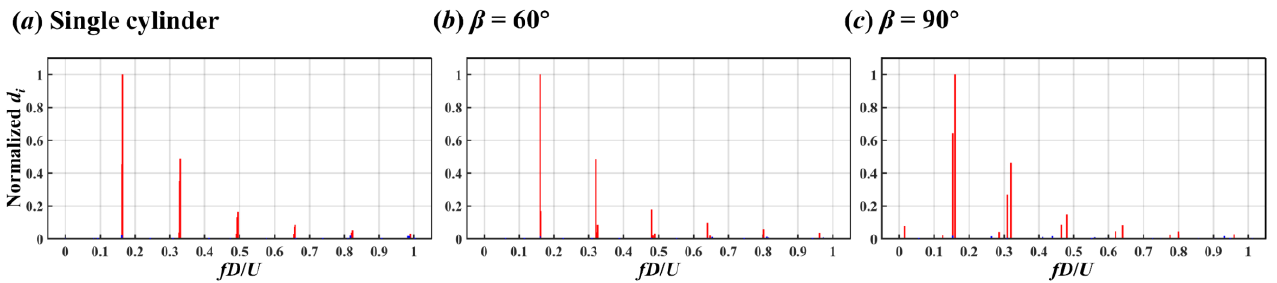
Figure 14. Spectral distribution of DMD modes for the cases of the single cylinder ( a ) and two cross-